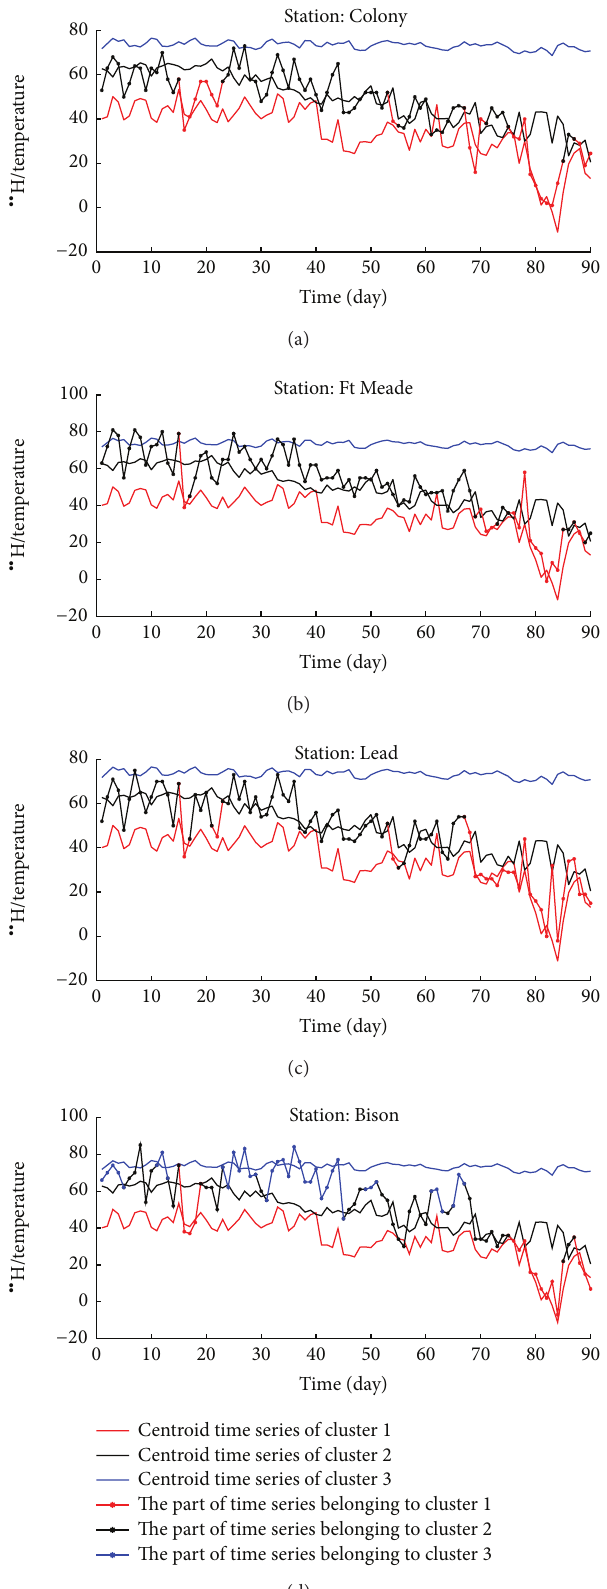
Figure 2: The dynamic behavior of the four switching time series over